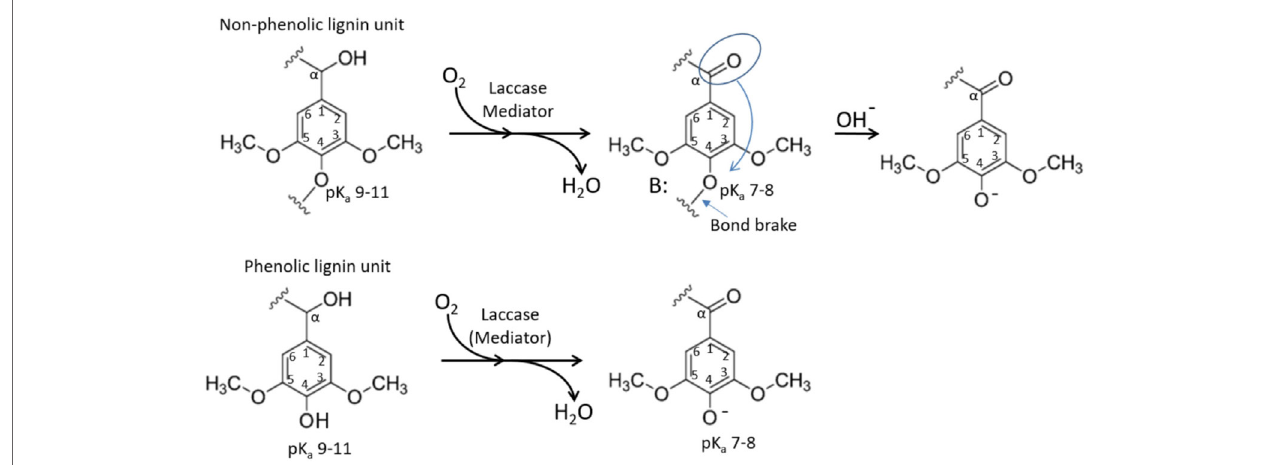
FigUre 6 | Schematic representation of laccase driven oxidation of a lignin unit. Oxidation of alpha-carbon to a ketone lowers pKa of the corresponding C1 hydroxyl, resulting in increased solubility in neutral-to-acidic pH and facilitated lignin chain